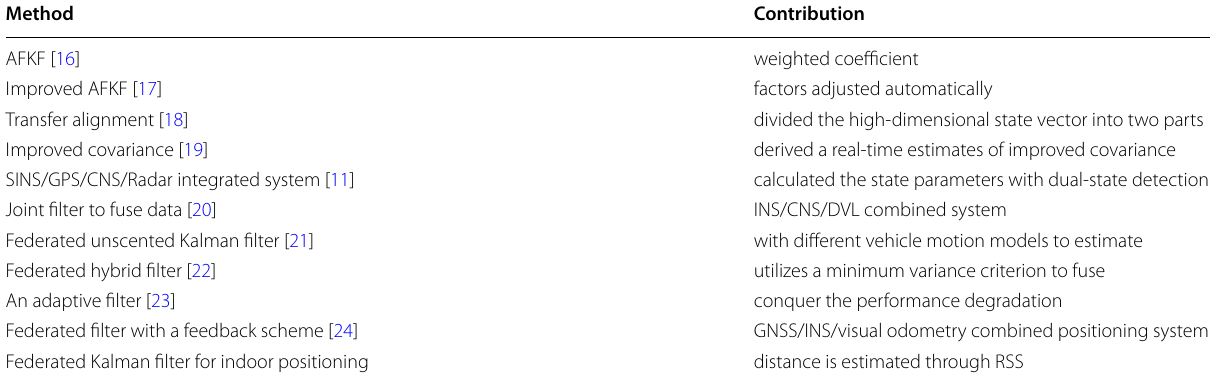
Table 1 The MSE comparison of different